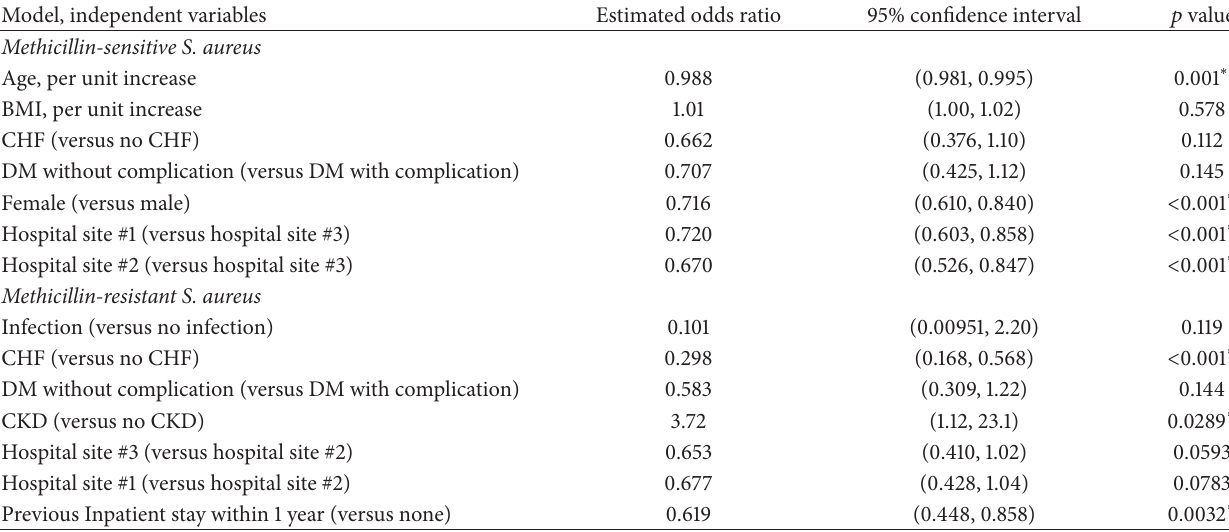
Table 4: Estimated odds ratios for patient acquiring S. aureus colonization, according to final multivariate logistic regression models. Model, independent